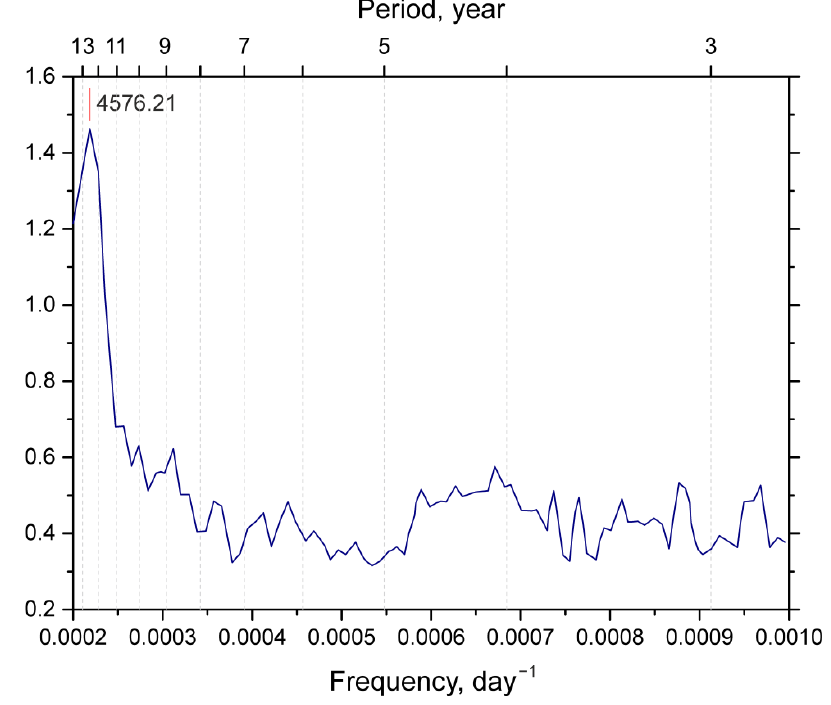
Figure 2. Periodogram of the mean zonal speed time series in 20 ± 2.5 °S latitude range for the trial period range of 5000 – 1000 days. Red mark indicates the period of 12.5 years, corresponding to the minimum of the phase dispersion parameter θ .